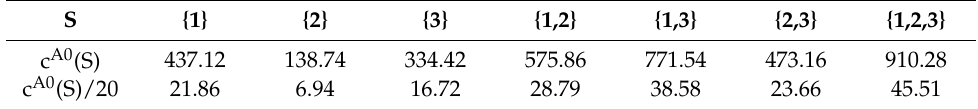
Table 19. The investment cost game ({1,2,3},cA0) under alternative A0.